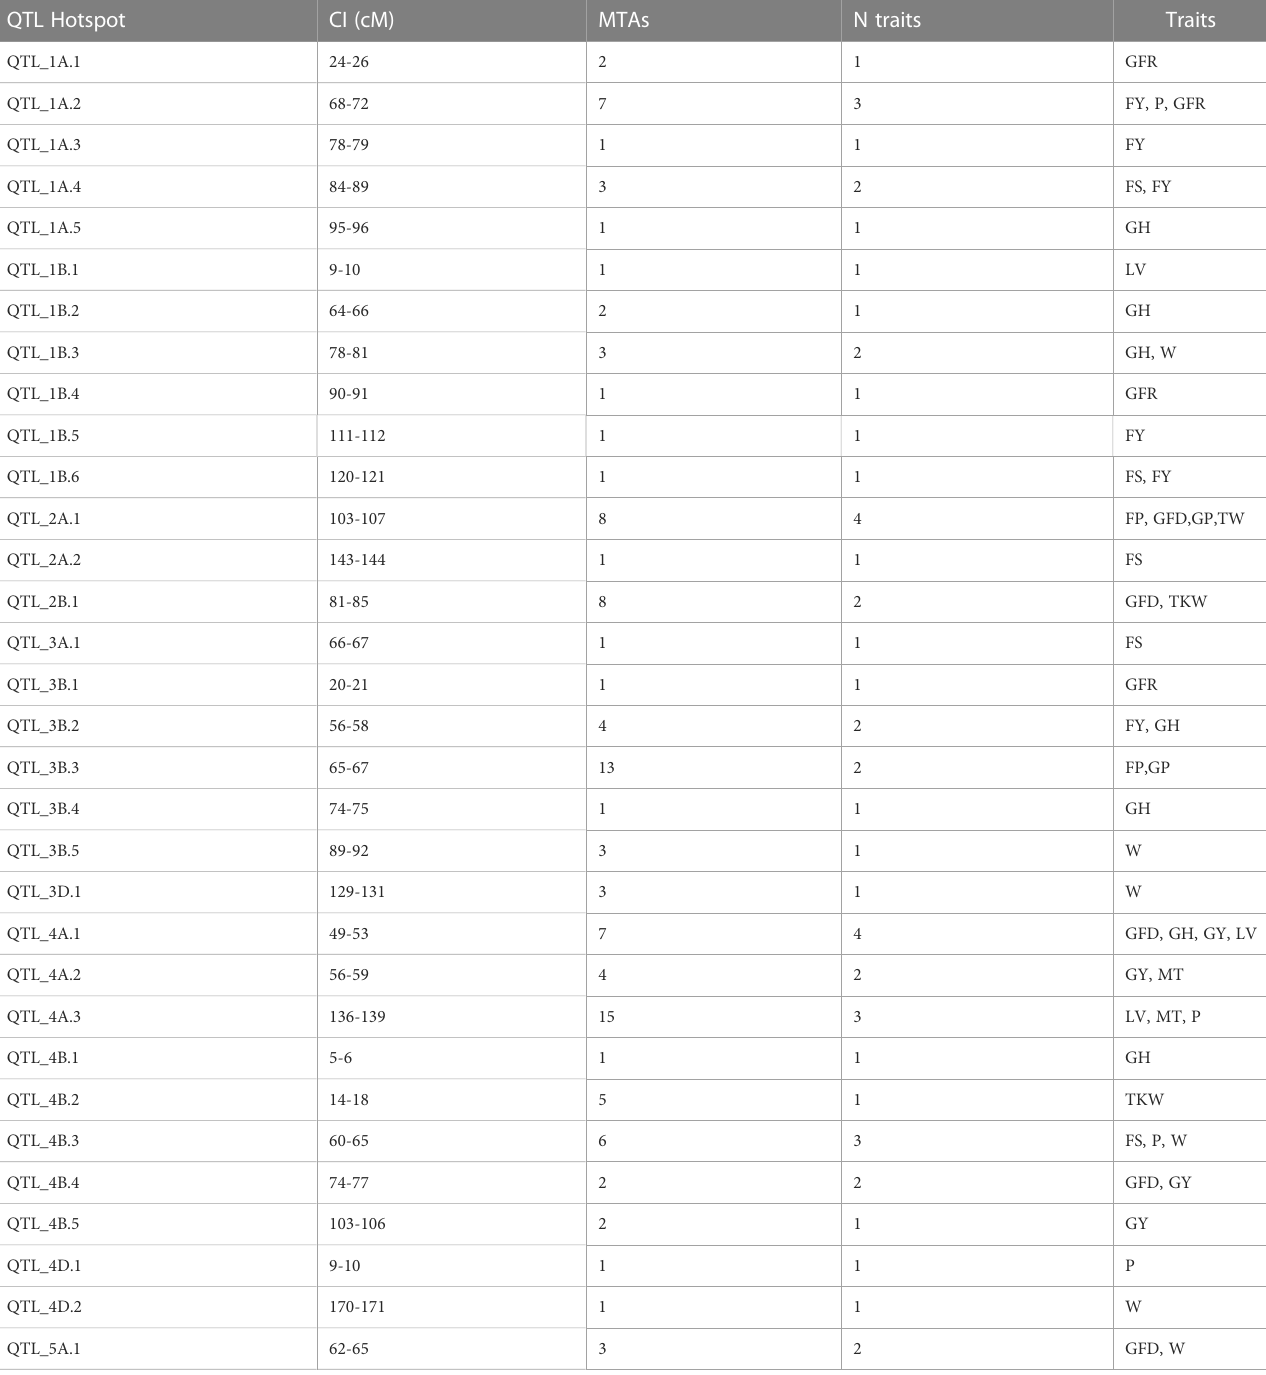
TABLE 3 Summary of QTL hotspots for quality and agronomic traits. QTL Hotspot CI (cM) MTAs N traits